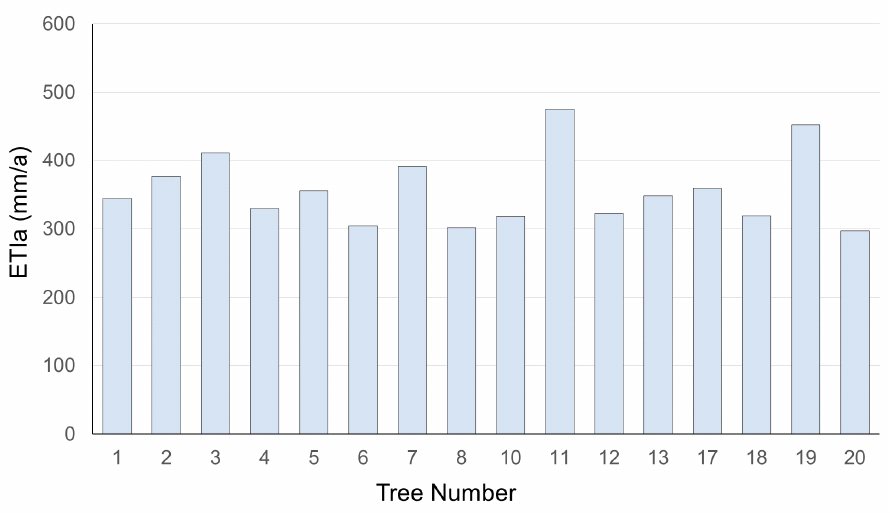
Figure 10. Long-term mean actual evapotranspiration, ETIa (mm/a) per m 2 catchment of the street trees at the Kufsteiner Straße, Berlin, Germany.